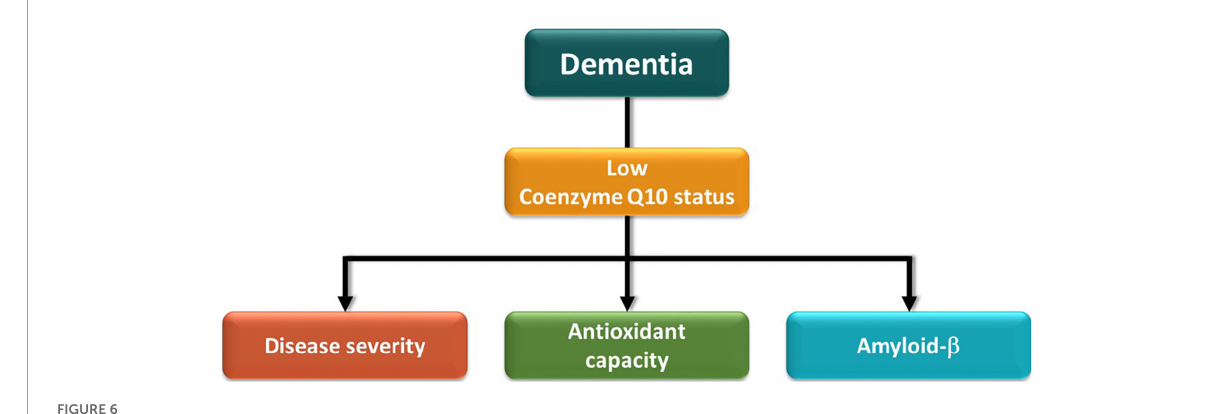
FIGURE6 Schematic representation of concluding